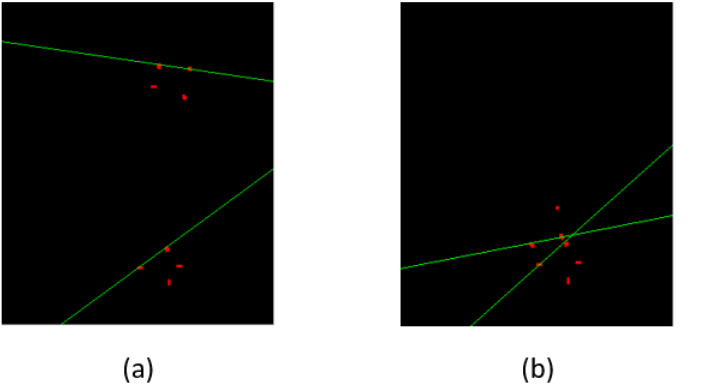
Figure 9. ( a ) Lines are passed through the corners of L1 and S to calculate the LLA ( b ), while lines are passed through the computed corners of L5 and S to calculate the